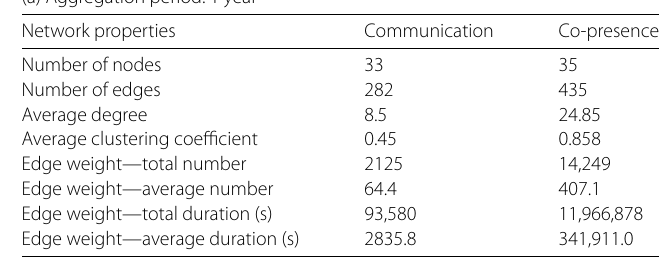
Table 1 Properties of the communication and co-presence networks (a) Aggregation period: 1